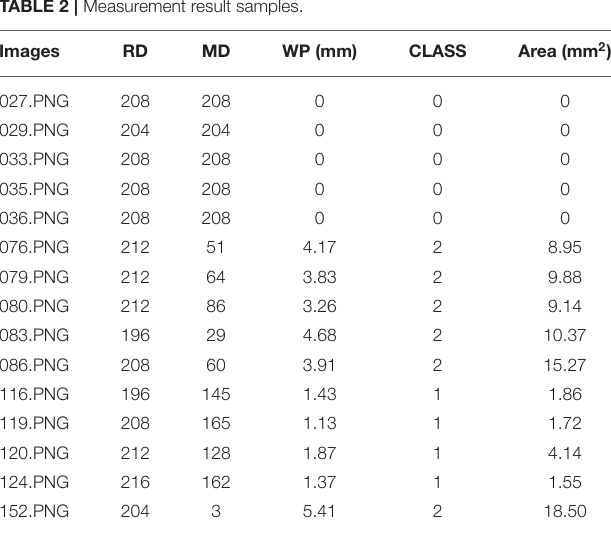
TABLE 2 | Measurement result